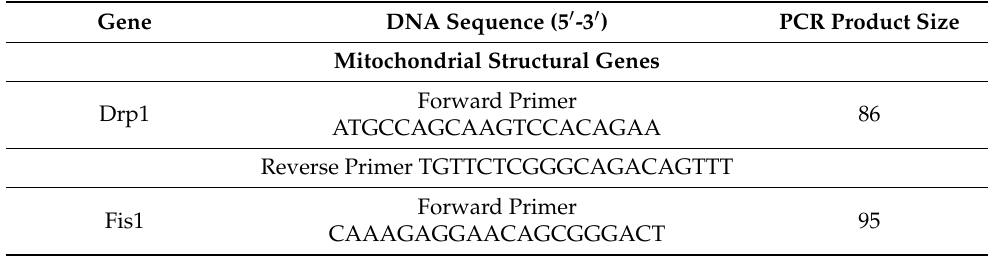
Table 1. Summary of q RT-PCR oligonucleotide primers used in measuring mRNA expression in mitochondrial structural, biogenesis, synaptic genes and autophagy and mitophagy genes. Gene DNA Sequence (5 (cid:48) -3 (cid:48)